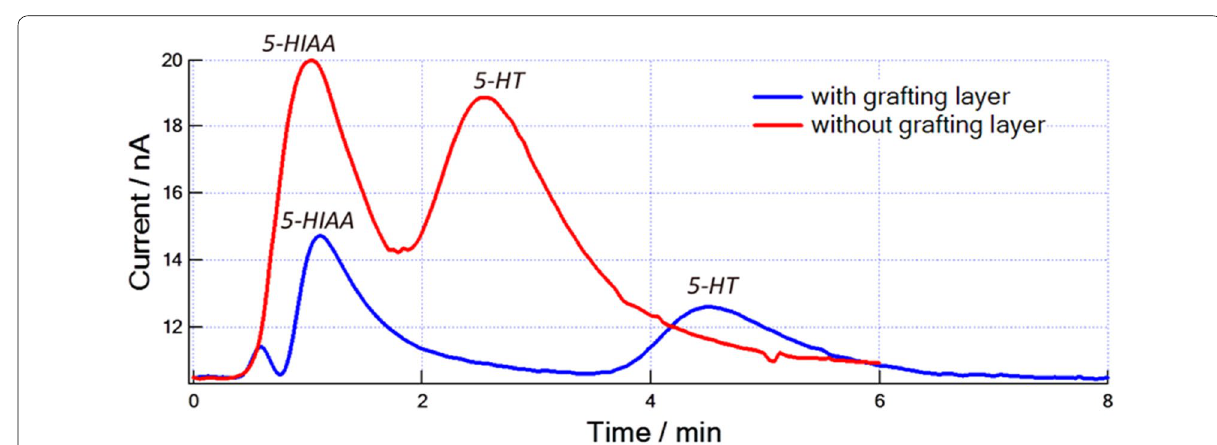
Fig. 6 Separation of neurotransmitters mixture at 150 µL/min using the poly(methyl acrylate) monolithic TPE column. [solutes: 5‑HIAA and